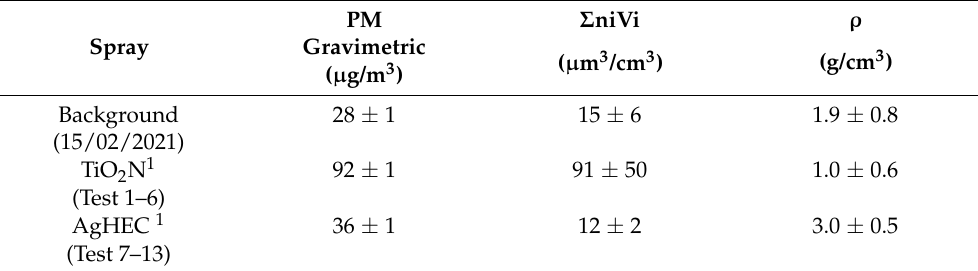
Table 1. Results of the field campaigns. Background subtracted.